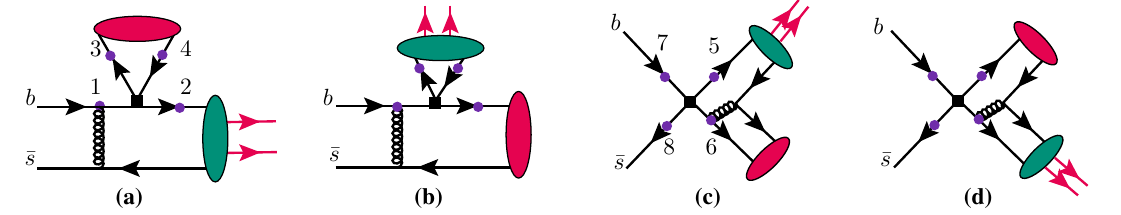
Fig. 1 Typical Feynman diagrams for the B 0 s → K K π in PQCD, where the black squares stand for the weak vertices, and large (purple) spots on the quark lines denote possible attachments of hard gluons. The green ellipses represent K π -pair and the red ones are the light bachelor